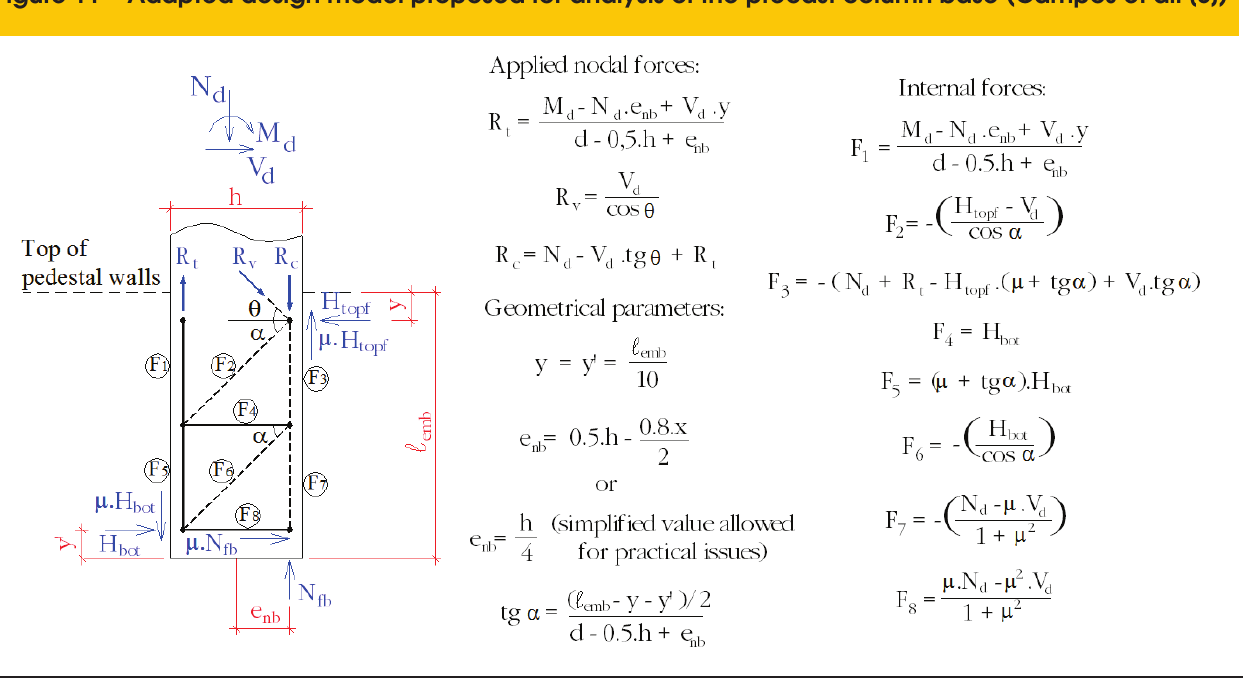
Figure 11 – Adapted design model proposed for analysis of the precast column base (Campos et al.